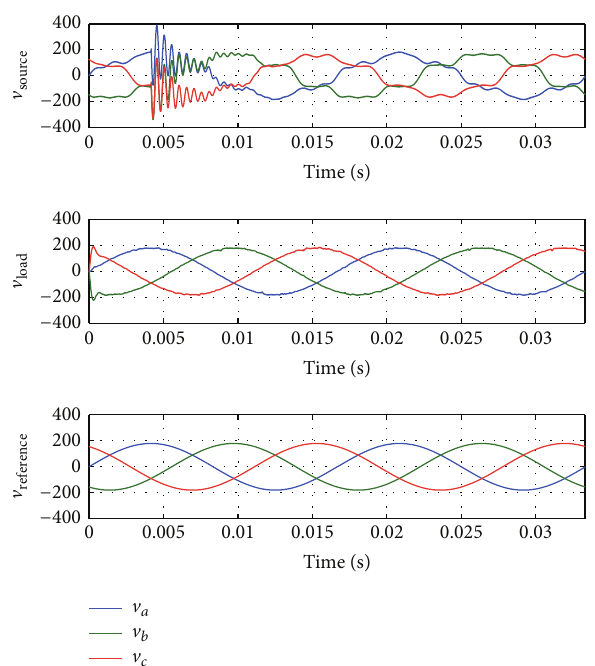
Figure 9: Current waveforms before and after compensation and reference signals. Figure 10: Voltage waveforms before and after compensation and reference